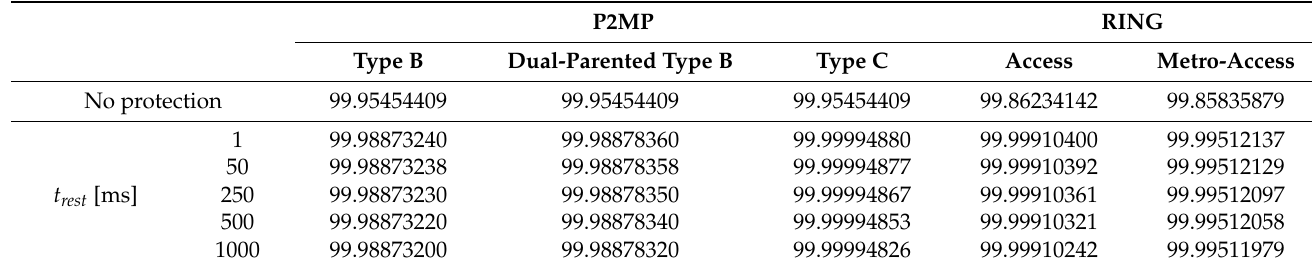
Table 4. The total WDM-PON network availability for selected restoration times.